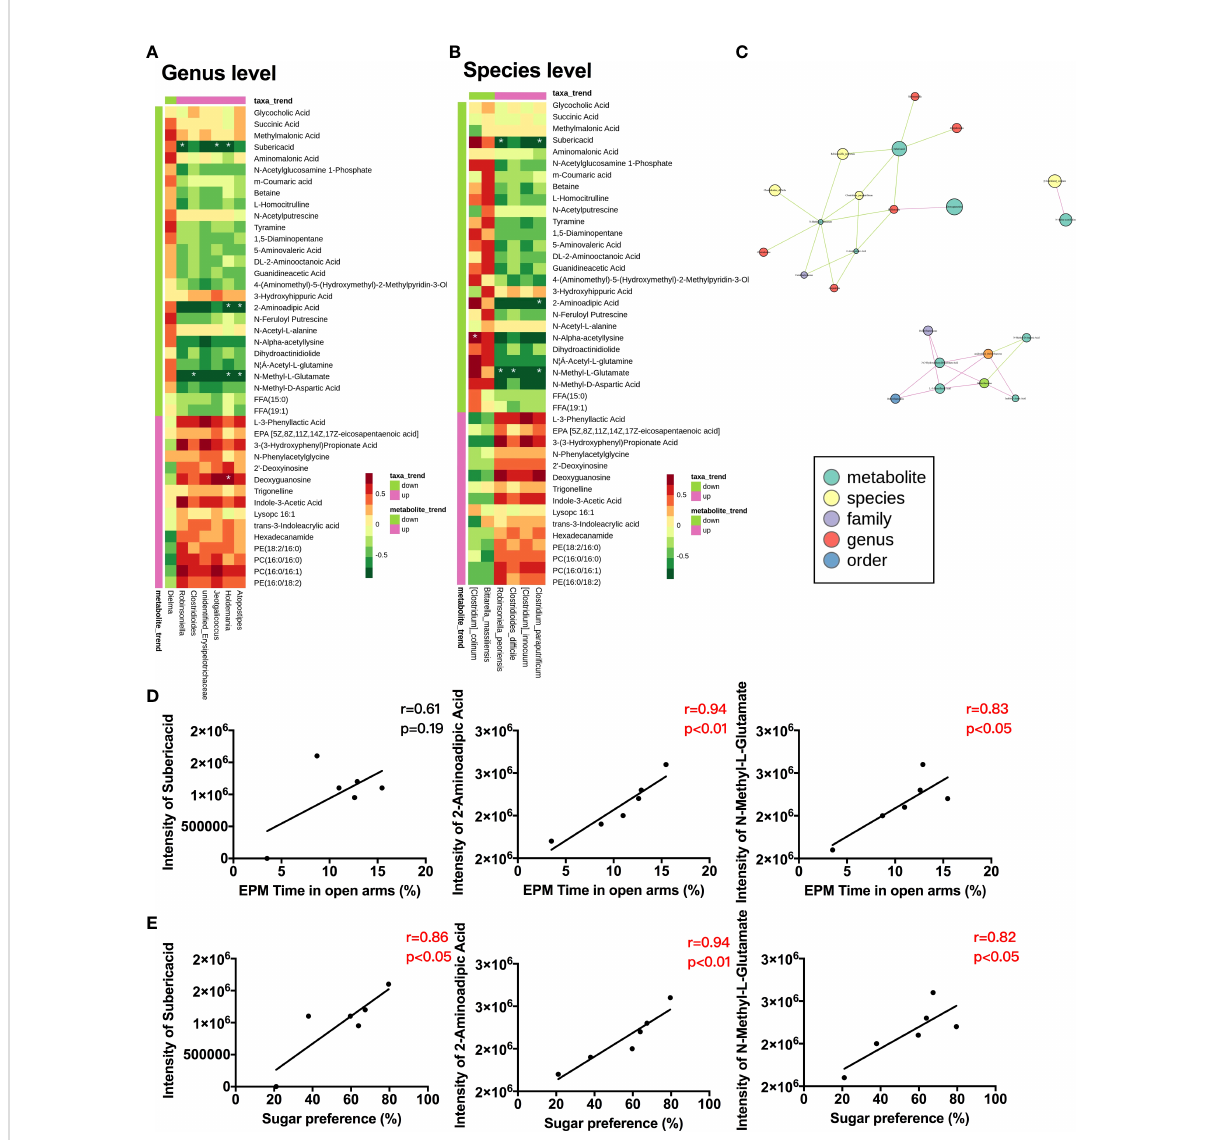
FIGURE 5 Correlations between host metabolites, gut microbiota, and behavioral changes (A) Correlation heatmap between metabolites and gut microbiota at genus level in CC and SS group (n = 6/group). (B) Correlation heatmap between metabolites and gut microbiota at the species level in CC and SS group (n = 4-6/group). (C) Total correlation network between metabolites and gut microbiota in CC and SS group (n = 4-6/group). (D) Correlations between metabolites and time spent in open arm in CC and SS group (n = 6/group). (E) Correlations between metabolites and sugar preference in CC and SS group (n = 6/group). * P< 0.05. CC, no stress; SS, preoperative stress and anesthesia/surgery